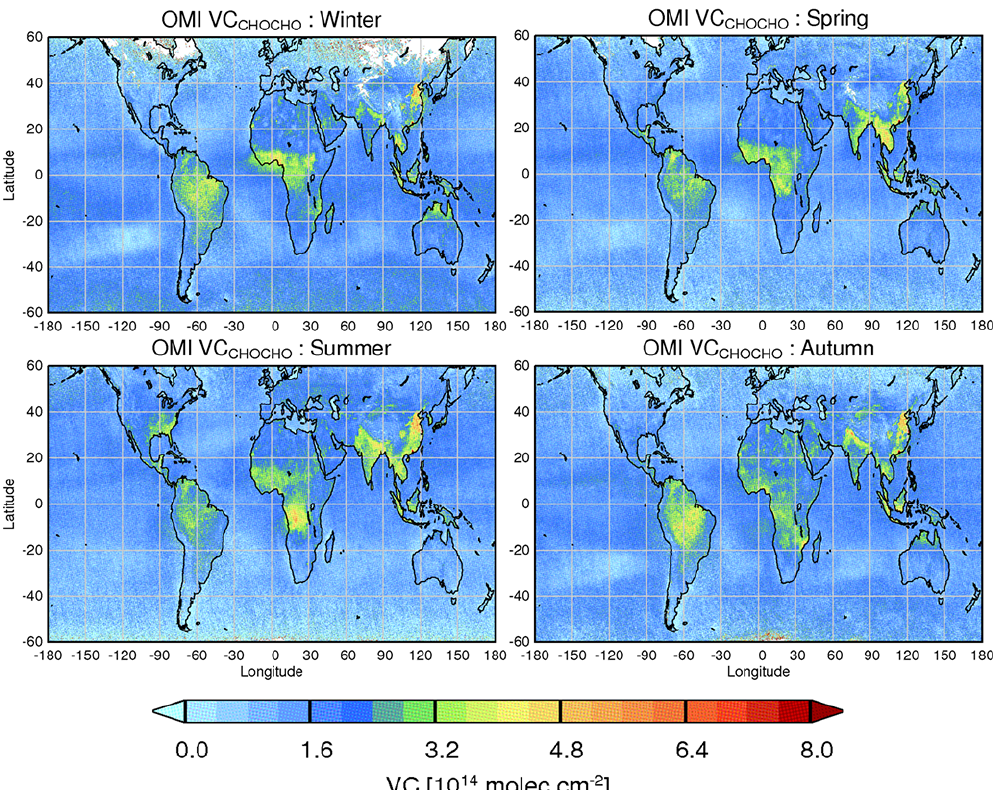
Figure 10. Seasonal means of CHOCHO VCs for winter (DJF), spring (MAM), summer (JJA), and autumn (SON) for the period 2005–2013.